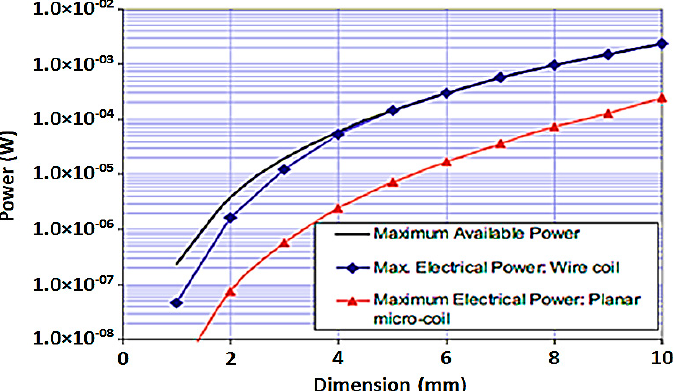
Figure 7. Highest possible electrical power generated from the wire coil and a micro-fabricated coil.